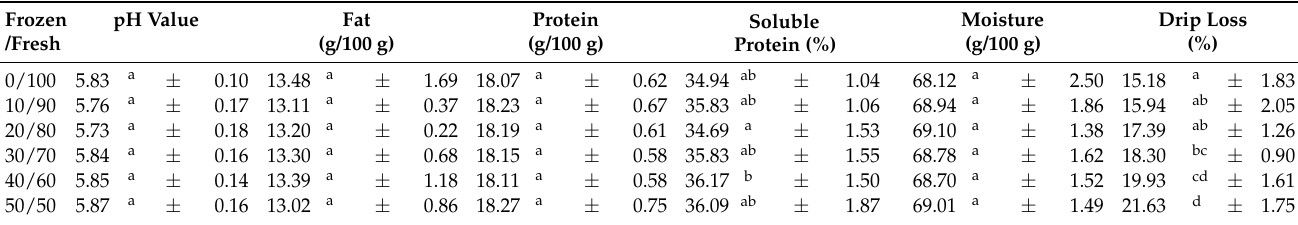
Table 1. pH value, fat, protein, soluble protein, and moisture content as well as drip loss (mean ± standard deviation) of minced meat with varying frozen to fresh meat ratios (n =